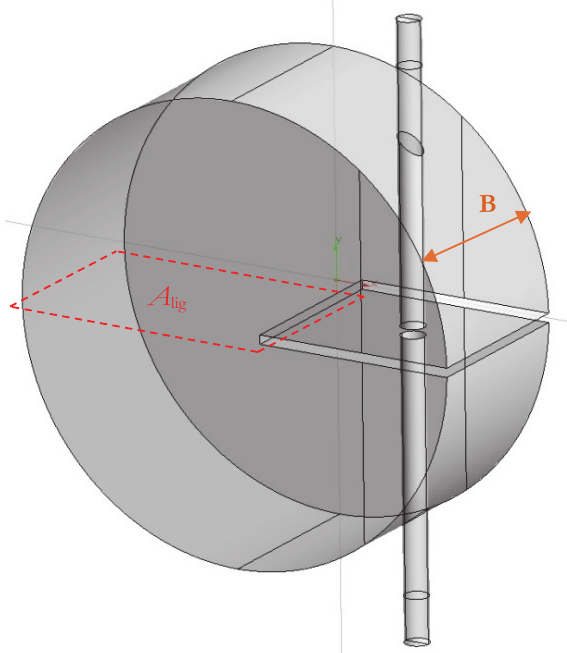
Figure 1: Visualization of a modified compact tension specimen in 3D